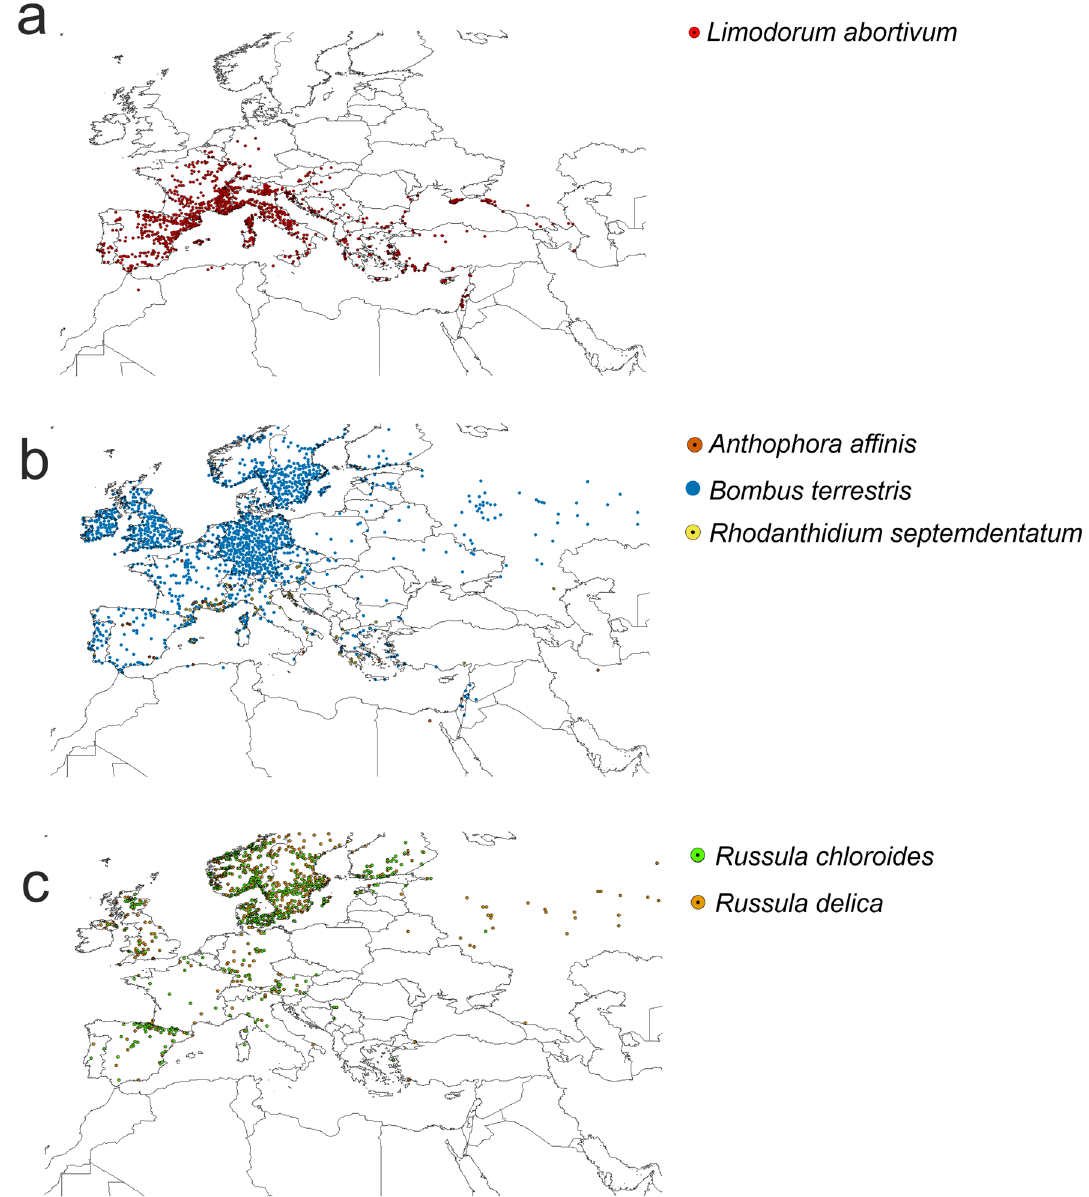
Figure 1. Localities of analysed species used in ENM analyses. ( a ) Limorodum abortivum , ( b ) pollinators, ( c ) fungal symbionts. Maps generated by the author in ArcGIS 47,48